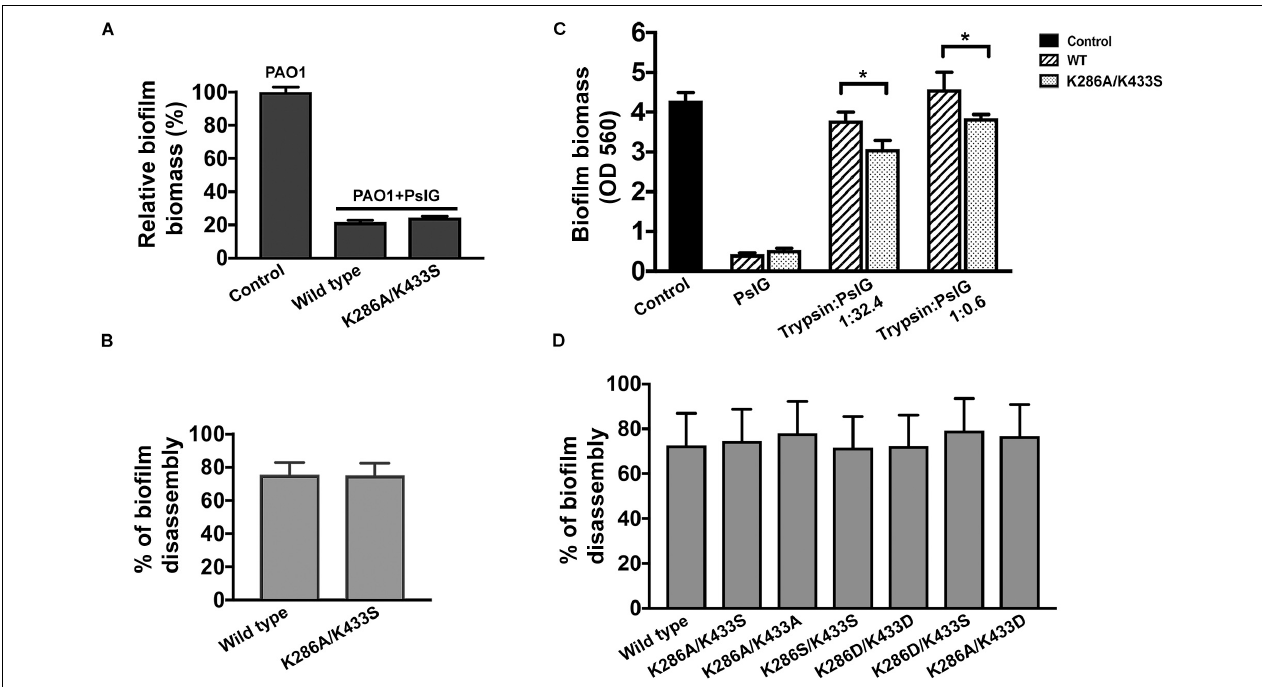
FIGURE 4 | Biofilm inhibition and disperse by wild-type and mutant PslG. (A) Biofilm inhibition by wild-type PslG and PslG K 286 A / K 433 S in the absence of trypsin. The sample without PslG treatment was used as control and set as 100%. (B) Biofilm disassembly by wild-type PslG and PslG K 286 A / K 433 S . The disassembly rates were calculated using the formula = [(A560 of untreated control - A560 of PslG-treated sample)/A560 of untreated control] × 100%. (C) Biofilm inhibition in the presence of different concentrations of trypsin. T -test was performed for testing differences between groups. * P < 0.05. (D) Biofilm disassembly by PslG K286/K433 mutants. The disassembly rates were calculated as described in (B) .